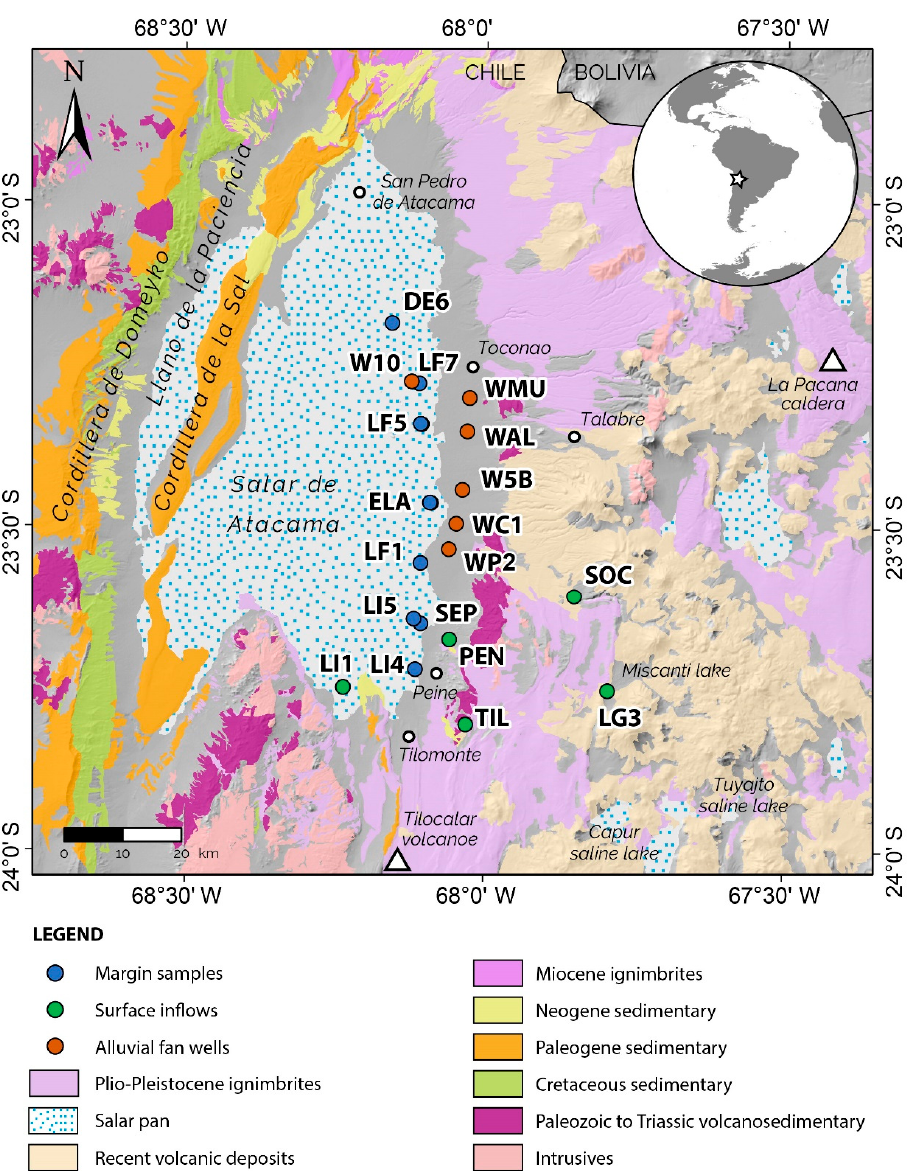
Figure 1. Map of the Salar de Atacama basin from References [36–38], showing the major rock units and the sample locations.